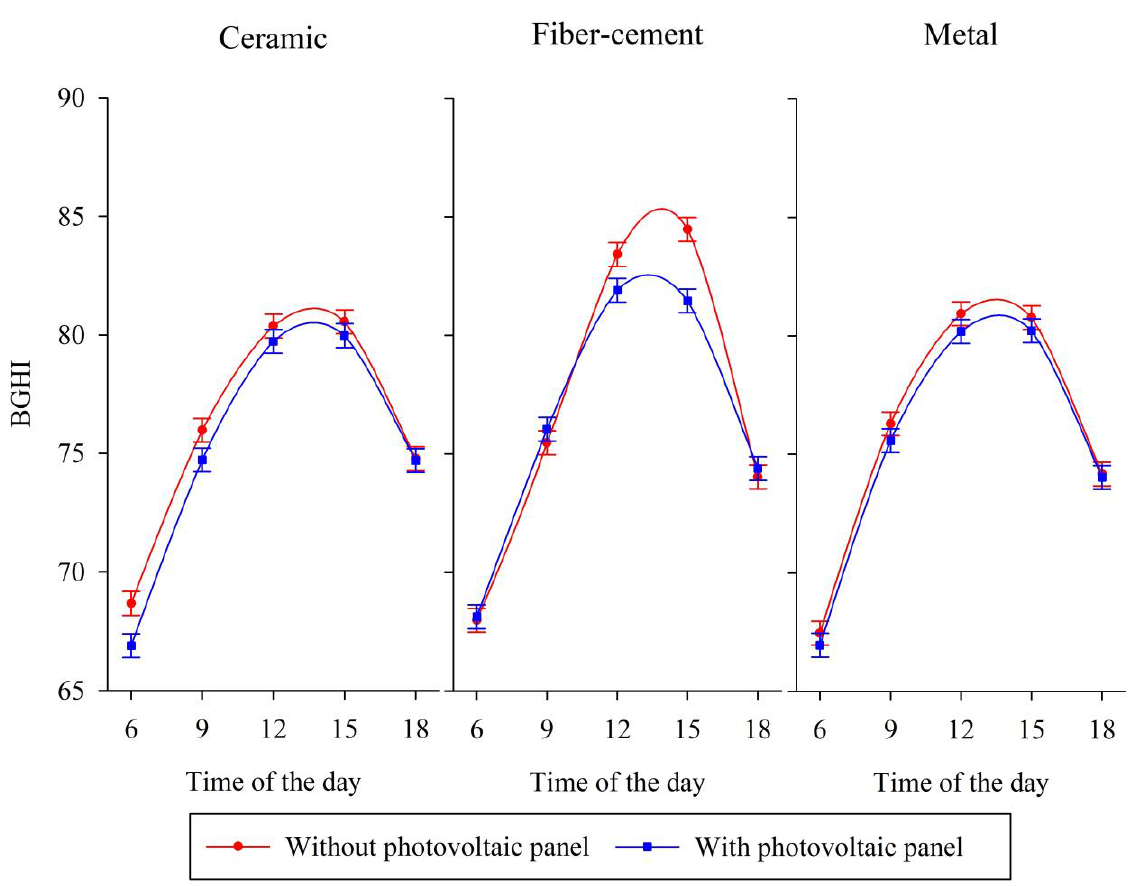
Figure 8. Behavior of the black and wet globe temperature index (BGHI) for the three types of tiles, with the presence and absence of the photovoltaic panel for ceramic, fiber-cement, and metallic tiles.